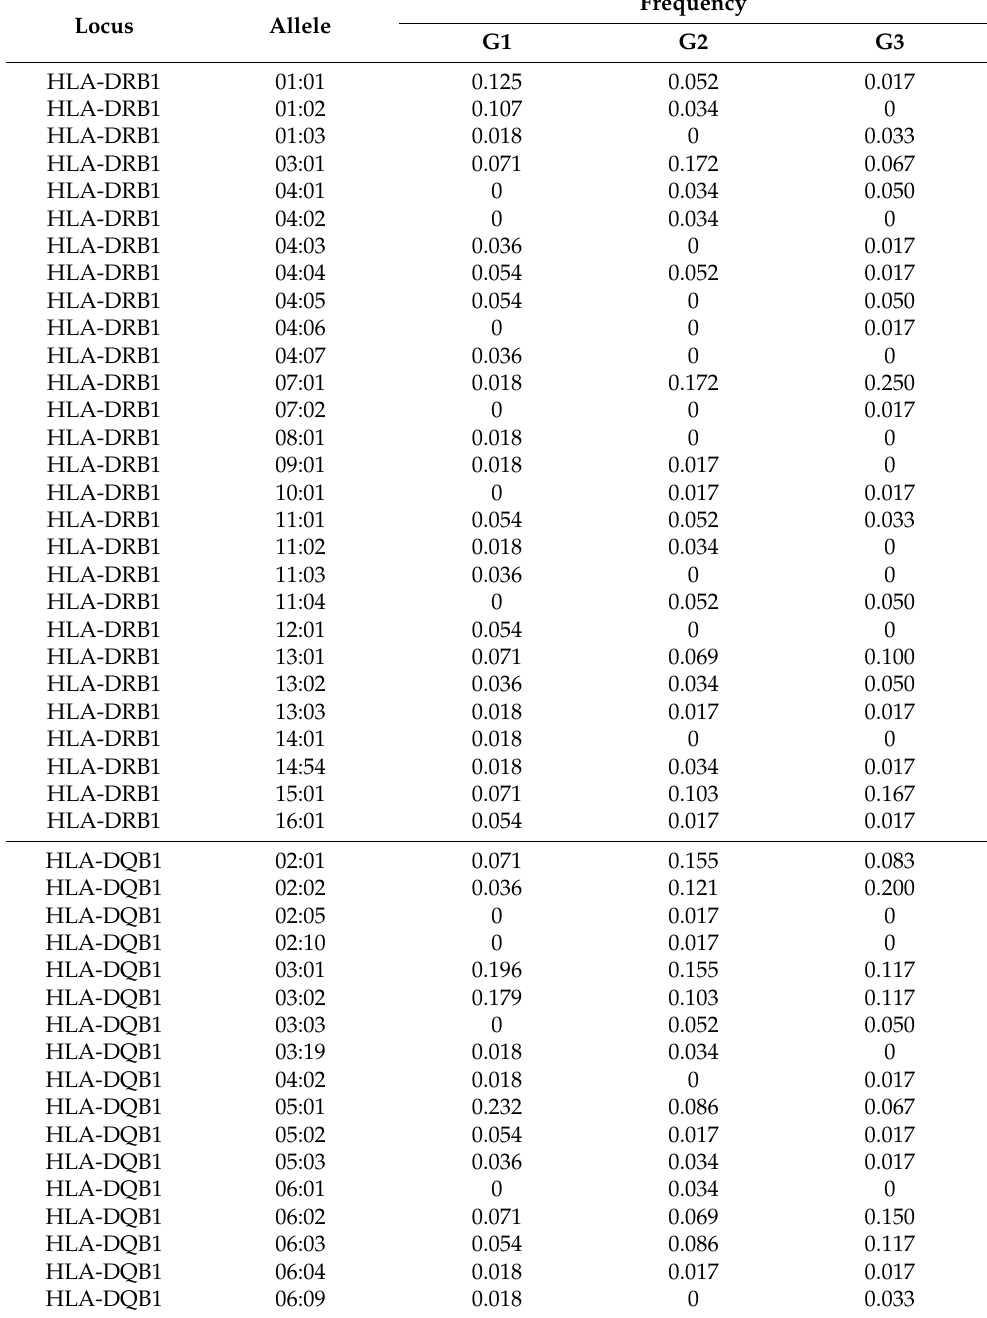
Table 1. Allele frequencies in the responder’s group.